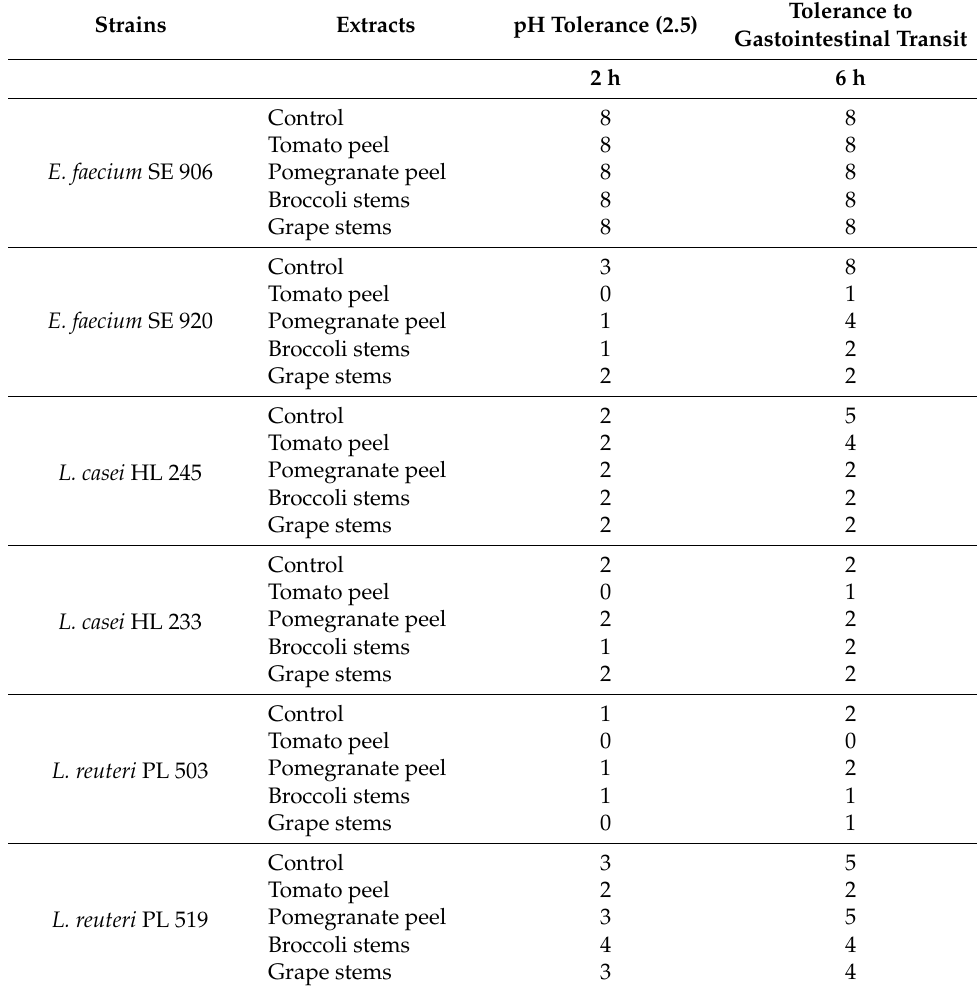
Table 2. Tolerance of bacterial strains to low pH, and complete gastrointestinal transit. Data are